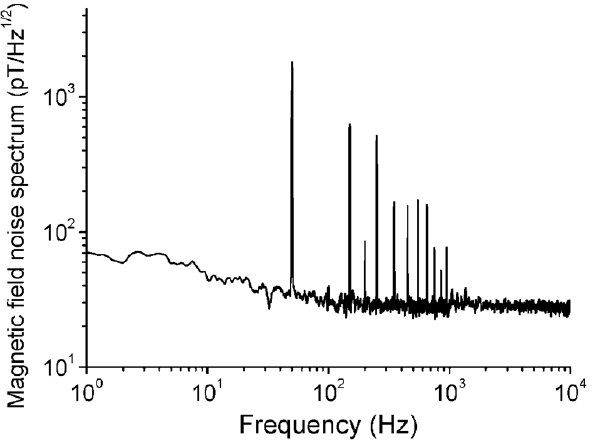
Figure 4. Magnetic field noise spectrum of the magnetic sensor measured in a 1 mm one layer permalloy shielding